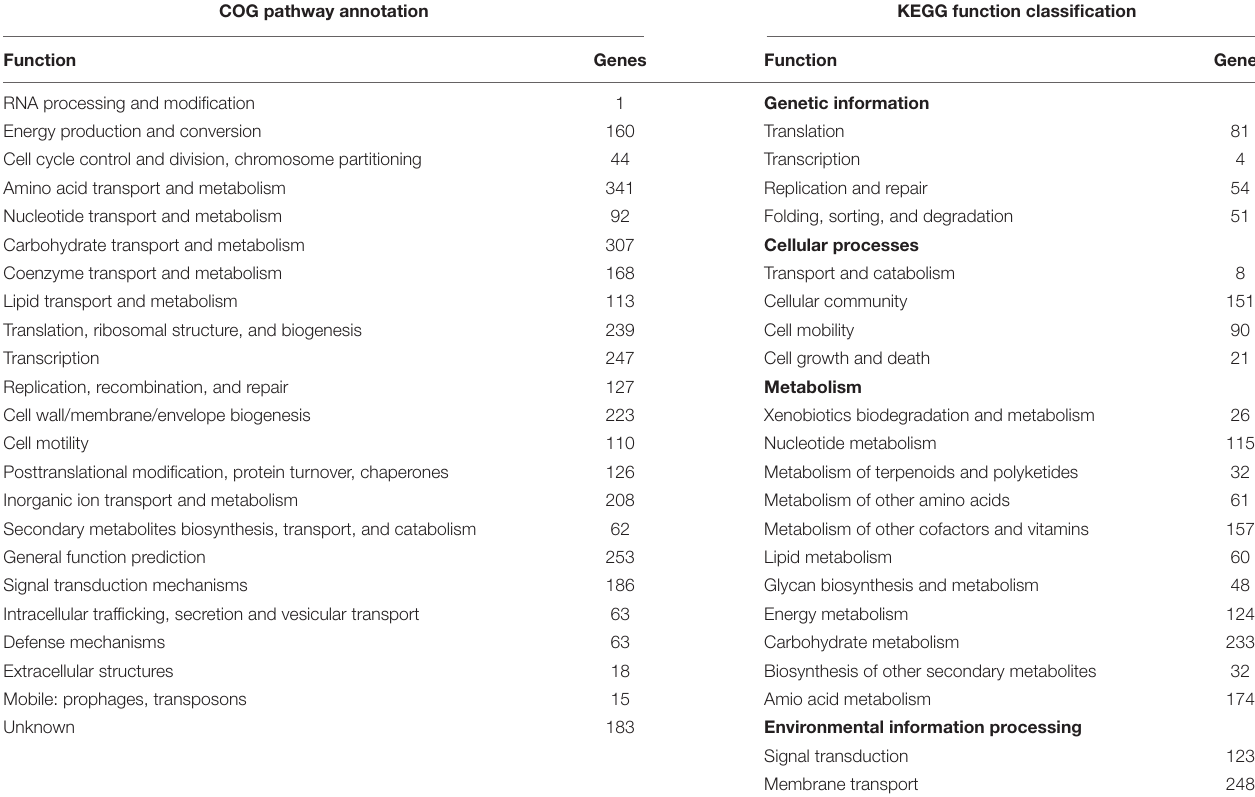
TABLE 1 | Genome features of